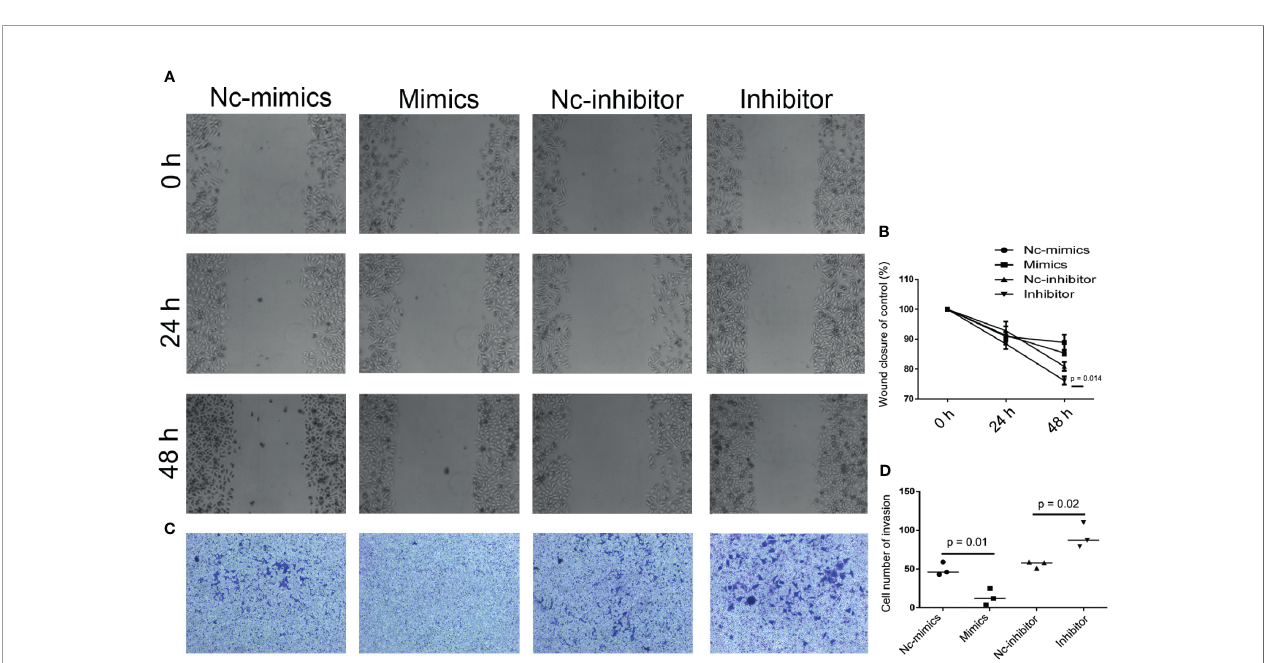
FIGURE 7 | Analysis of cell migration and invasion after miR-29b knockdown and overexpression. (A) To determine the effect of miR-29b-3p on cell migration, cell migration was analyzed in Nc-mimics, miR-29b-3p-mimics, Nc-inhibitor, and miR-29b-3p-inhibitor groups, respectively, in SCC9 cells. (B) Statistical analysis of the percentage of cell migration among the four groups. (C) To determine the effect of miR-29b-3p on cell invasion, Cell invasion was analyzed in Nc-mimics, miR-29b- 3p-mimics, Nc-inhibitor, and miR-29b-3p-inhibitor groups, respectively, in SCC9 cells. (D) Statistical analysis of the percentage of cell invasion among the four groups. Statistical signi fi cances between groups were evaluated using t-test for independent